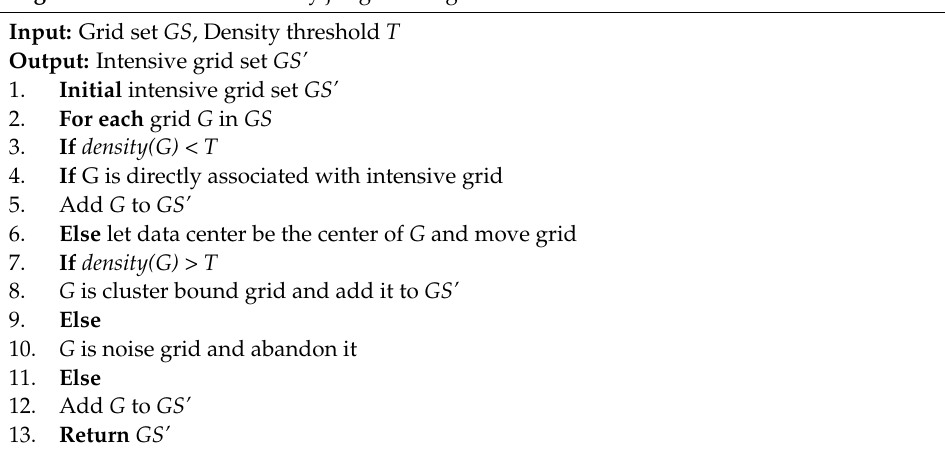
Figure 3. Judgment of cluster boundary points. Algorithm 1. Cluster boundary judgment